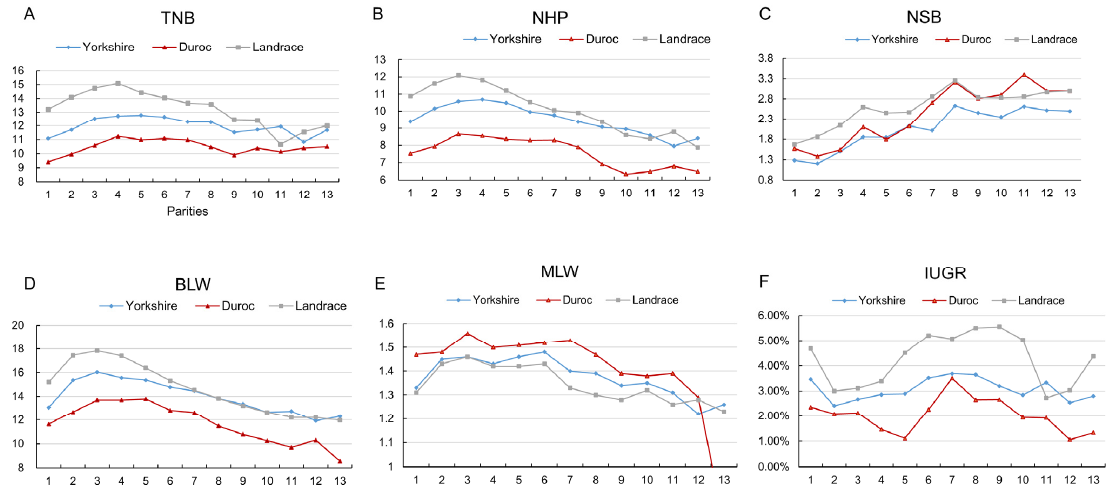
Figure 1. Reproductive performance of different parities sows. ( A ) TNB of different parities sows; ( B ) NHP of different parities sows; ( C ) NSB of different parities sows; ( D ) BLW of different parities sows; ( E ) MLW of different parities sows; ( F ) IUGR of different parities sows. Note: TNB: total number born; NHP: number of healthy piglets; BLW: birth litter weight; MLW: mean litter weight; NSB: number of stillbirth. IUGR: intrauterine growth